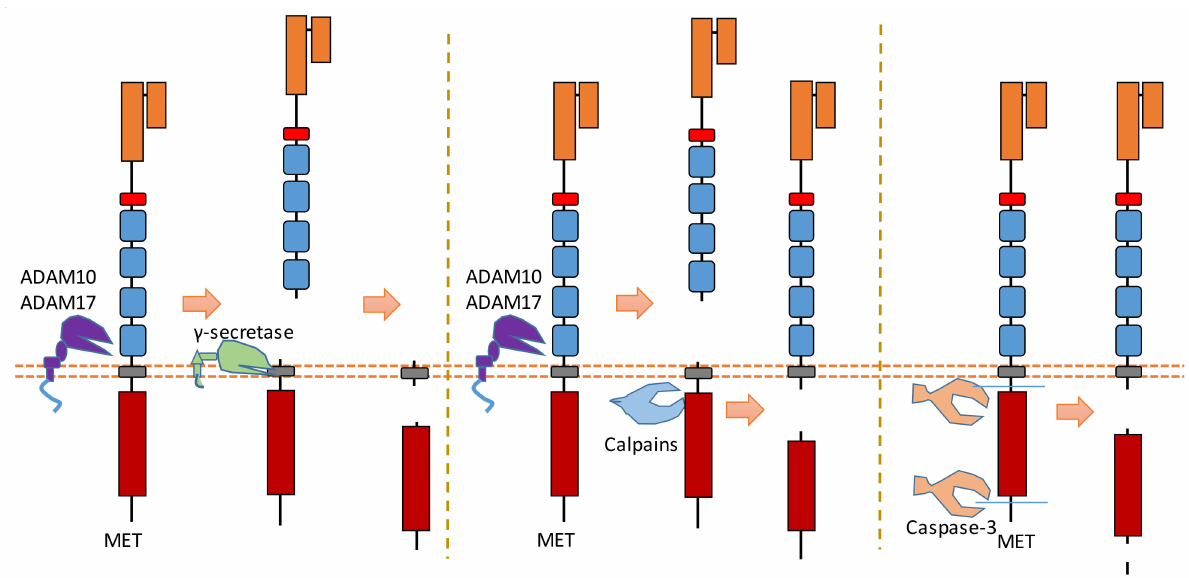
Figure 4. Schematic illustration of proteolytic cleavage in